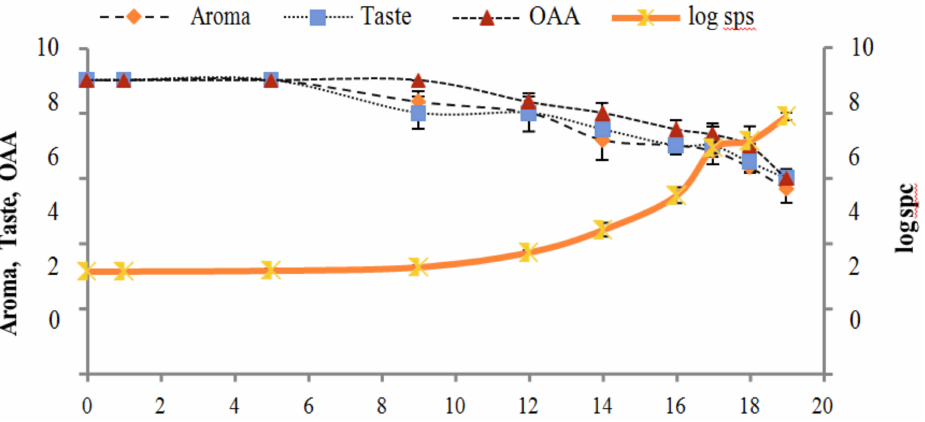
Figure 5. Relationship of standard plate count log cfu/mL growth trends with sensory scores of pasteurized milk for spoilage detection stored at 4 ◦